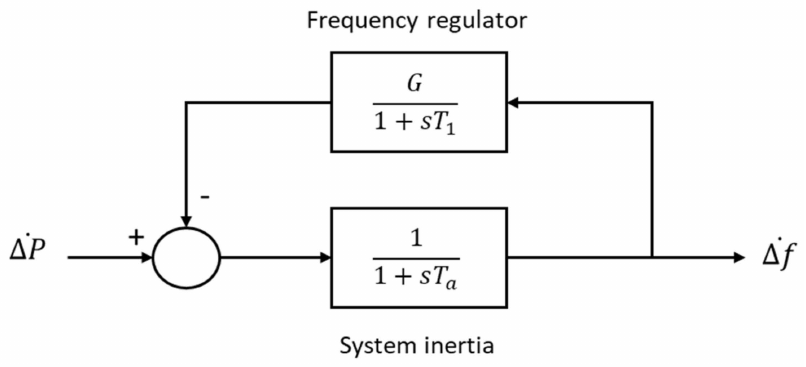
Figure 11. The single bus power system